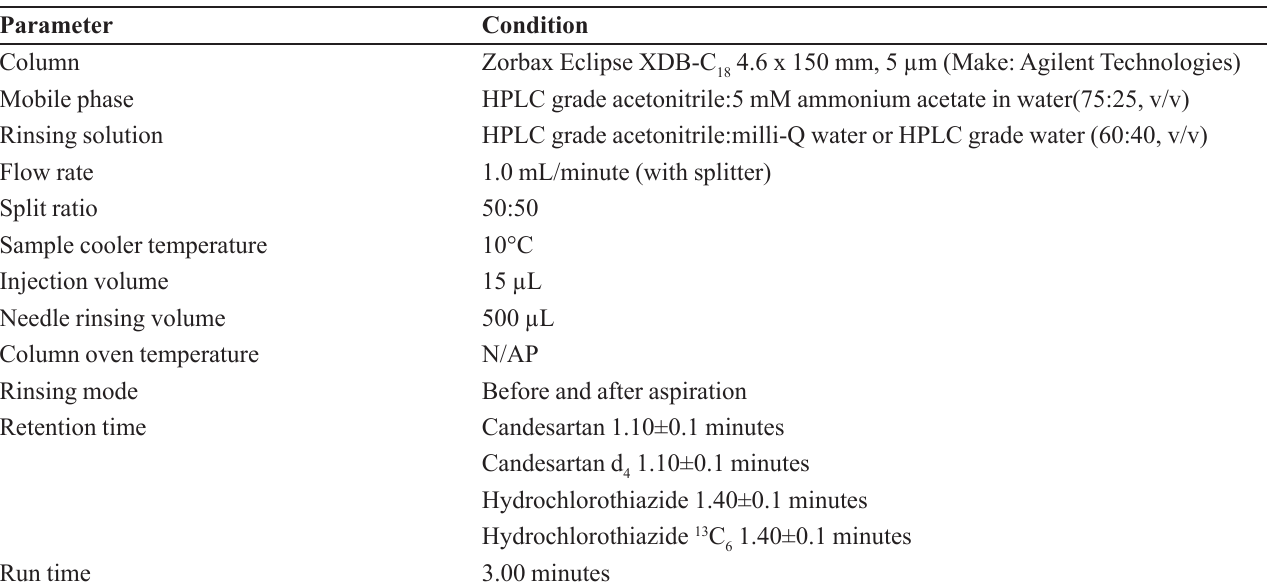
TABLE I - Summary of optimized conditions